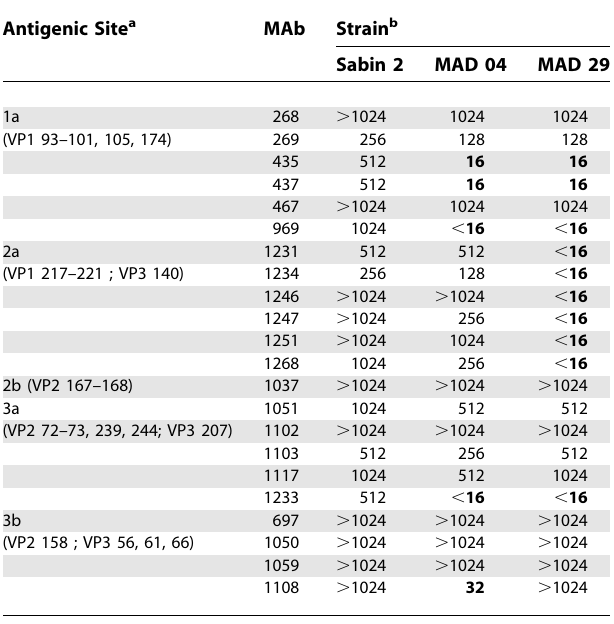
Table 3. Phenotypic Markers of the VDPVs and Other Poliovirus